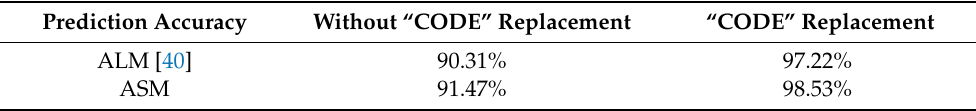
Figure 5. Training loss-gradient curve overlaid with validation loss-gradient curve of the DSAMM, where the curve smoothness is set to 0.7, and the opaque curve is after the smoothing setting and the translucent curve is the original loss gradient curve. Figure 5 shows that the training loss value of the DSAMM decreases rapidly before the steps of training iterations are 1k, indicating the model ’ s excellent learning ability and ability to make a good assessment of whether address pairs match even before the dataset is en- tirely learned. This has inspired us to investigate whether better matching can be achieved even with microsupervision, that is, with a small amount of supervised training data.